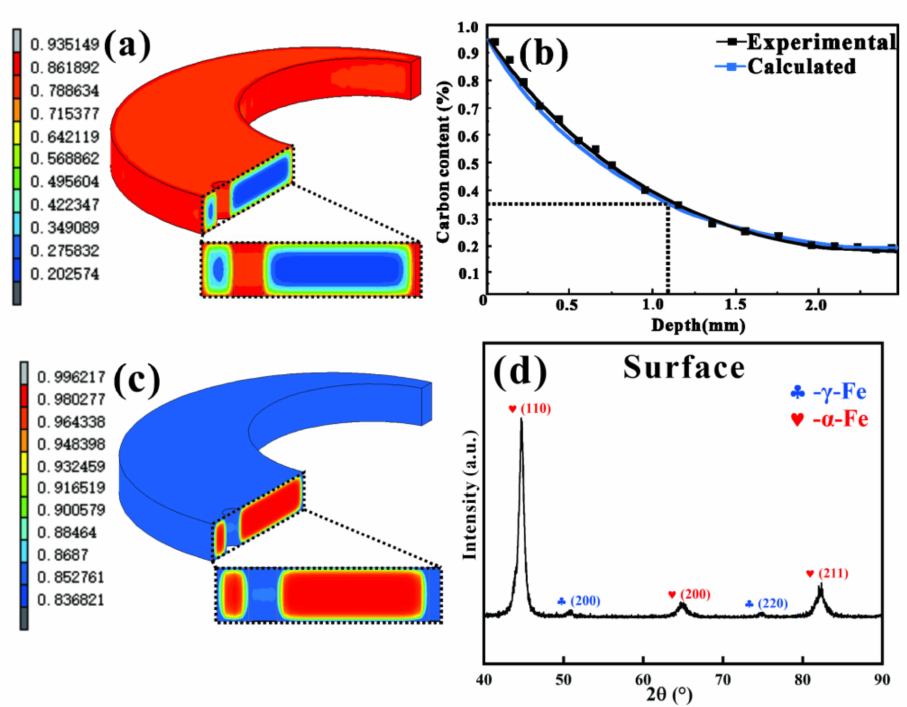
Figure 8. ( a ) Carbon concentration distribution; ( b ) the calculated and experimental carbon concer- tation distribution of the carburized layer; ( c ) martensite content distribution at different positions; ( d ) XRD diffraction pattern measured by the experiment on the surface layer of the specimen.